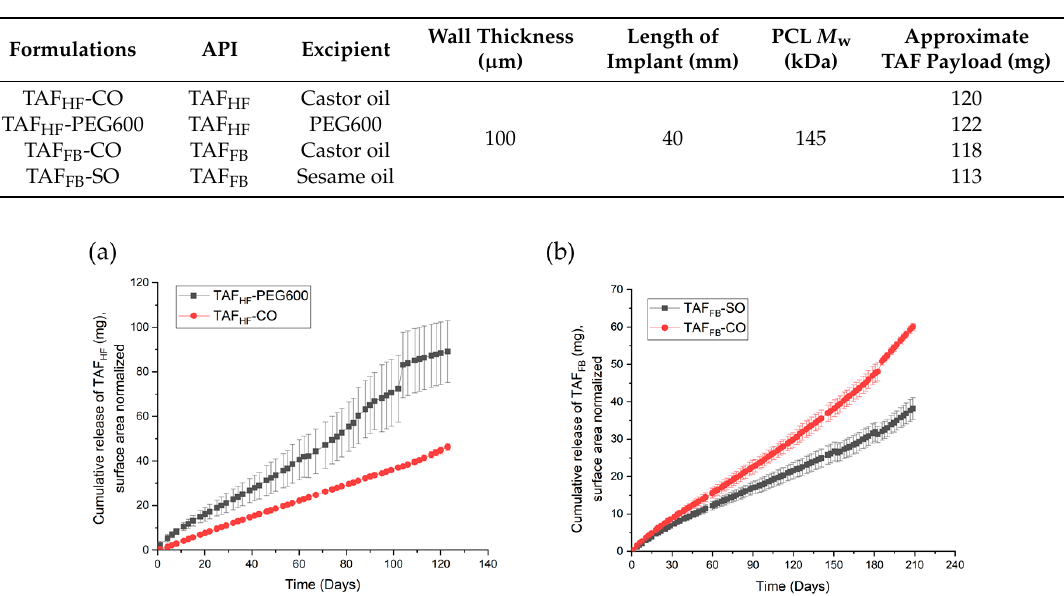
Table 2. The formulation and PCL membrane configuration for tested implants.